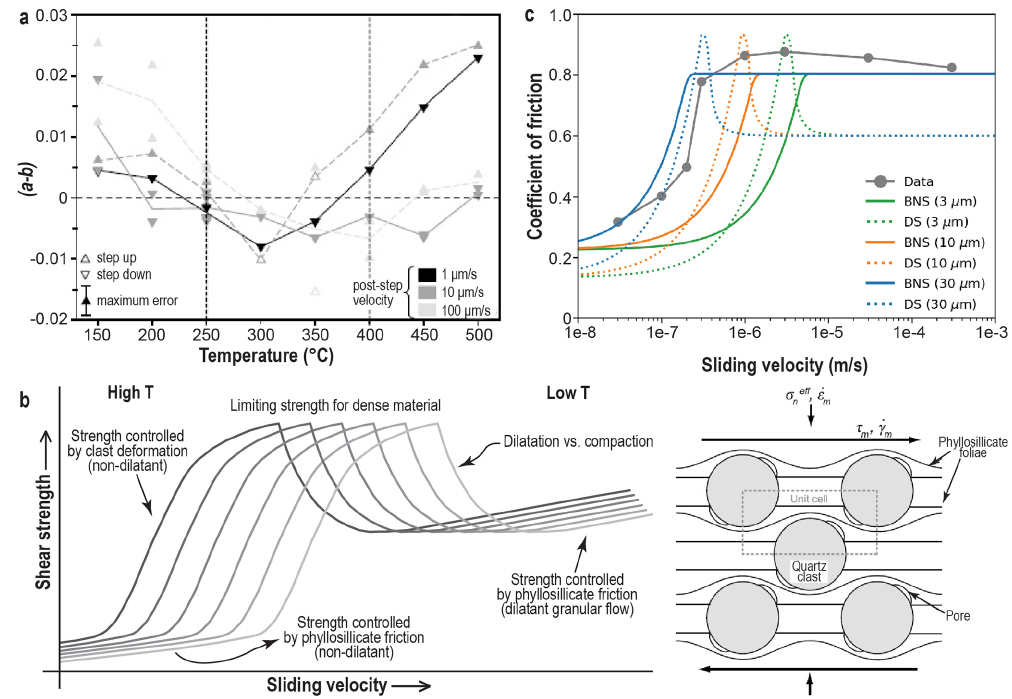
Figure 4. Data from hydrothermal ring-shear experiments on quartz–phyllosilicate mixtures. (a) Three regimes of v dependence seen in experiments on illite–quartz mixtures (taken with publisher’s permission from Den Hartog and Spiers, 2014). (b) Conceptual interpretation of quartz–phyllosilicate strength evolution with sliding velocity and temperature (left) (taken with publisher’s permission from Den Hartog and Spiers, 2013) and the model microstructure envisioned by Den Hartog and Spiers (2014) (DS model, right). (c) Coefficient of friction at steady state against sliding velocity including data from constant- v experiments by Niemeijer (2018) in grey. The coloured curves are generated using the model for frictional–viscous deformation (BNS, solid lines) (Bos and Spiers, 2002a; Niemeijer and Spiers, 2005) and using the DS model (dashed lines) for different nominal grain sizes as indicated. The peaks mark a transition from v strengthening to v weakening (taken with publisher’s permission from Niemeijer,